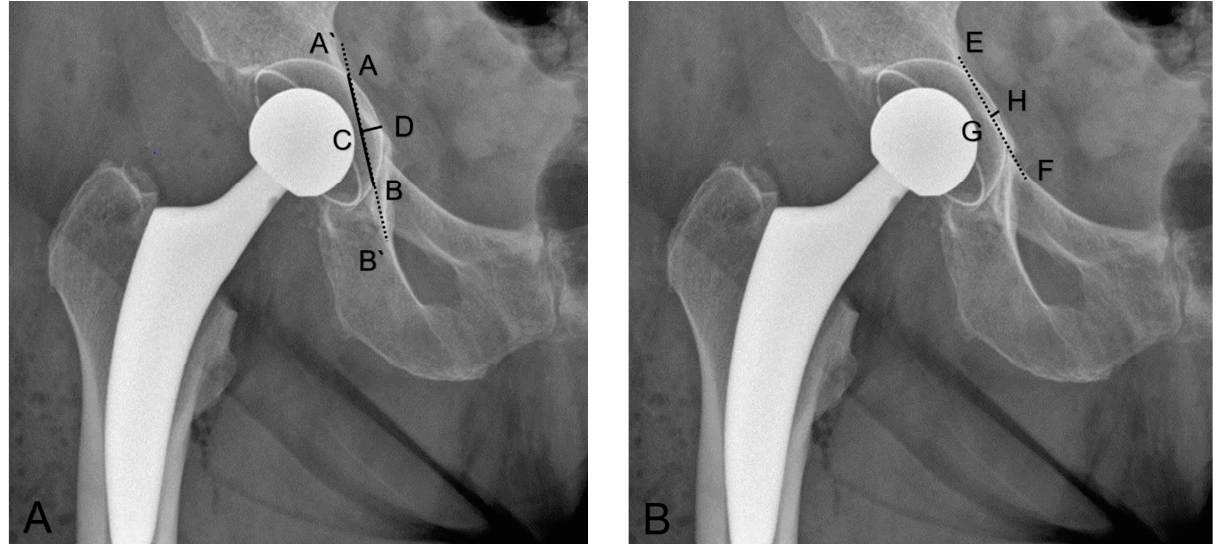
Figure 2. Radiographic measurements of the medial cup protrusion. ( A ). AB length of the overlap tangent was defined as the distance between the two crossings of A`B` the ilioischial line and the cup; CD ilioischial overlap as the distance between the ilioischial line and the tangent of the acetabular cup medial. ( B ). GH iliopectineal distance as the minimal distance between the iliopectineal line (EF) and the cup [4].